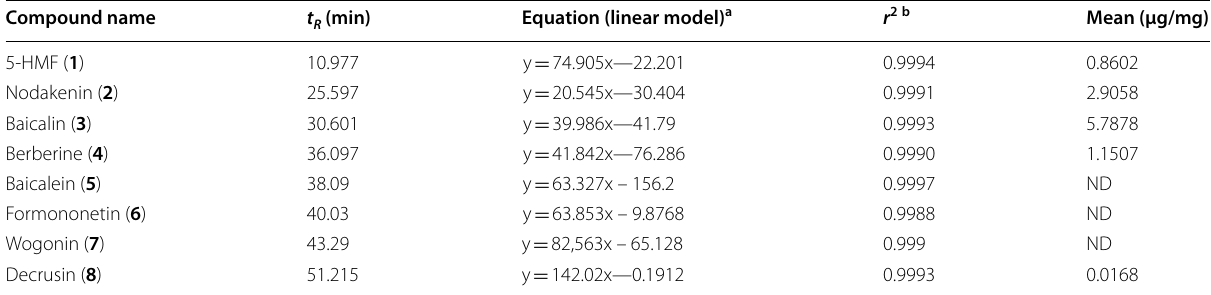
Table 1 Linearity and contents (ug/mg) of DYT